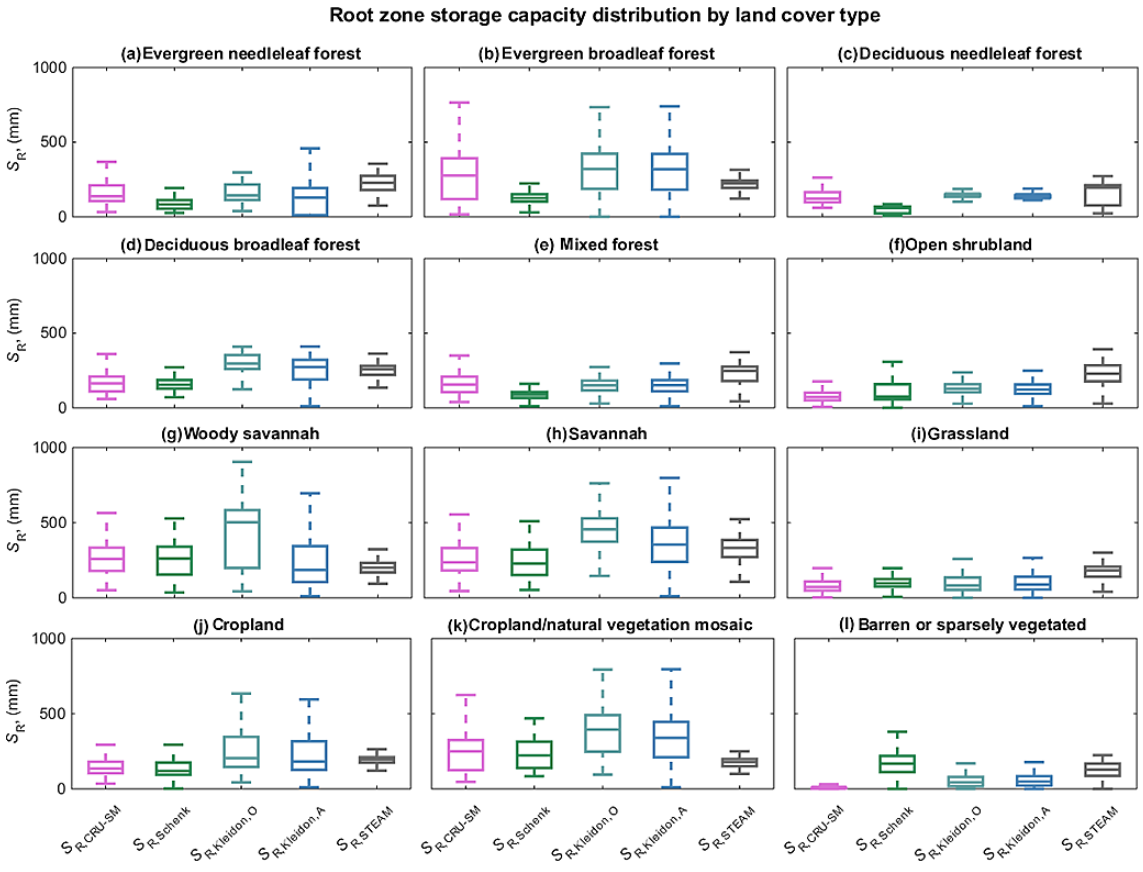
Figure 5. Comparison of root zone storage capacity estimates by land cover type using Tukey box plots. The central markers of the boxes mark the median, and the box edges mark the 25th and 75th percentile. The whiskers extend to 1.5 times the interquartile